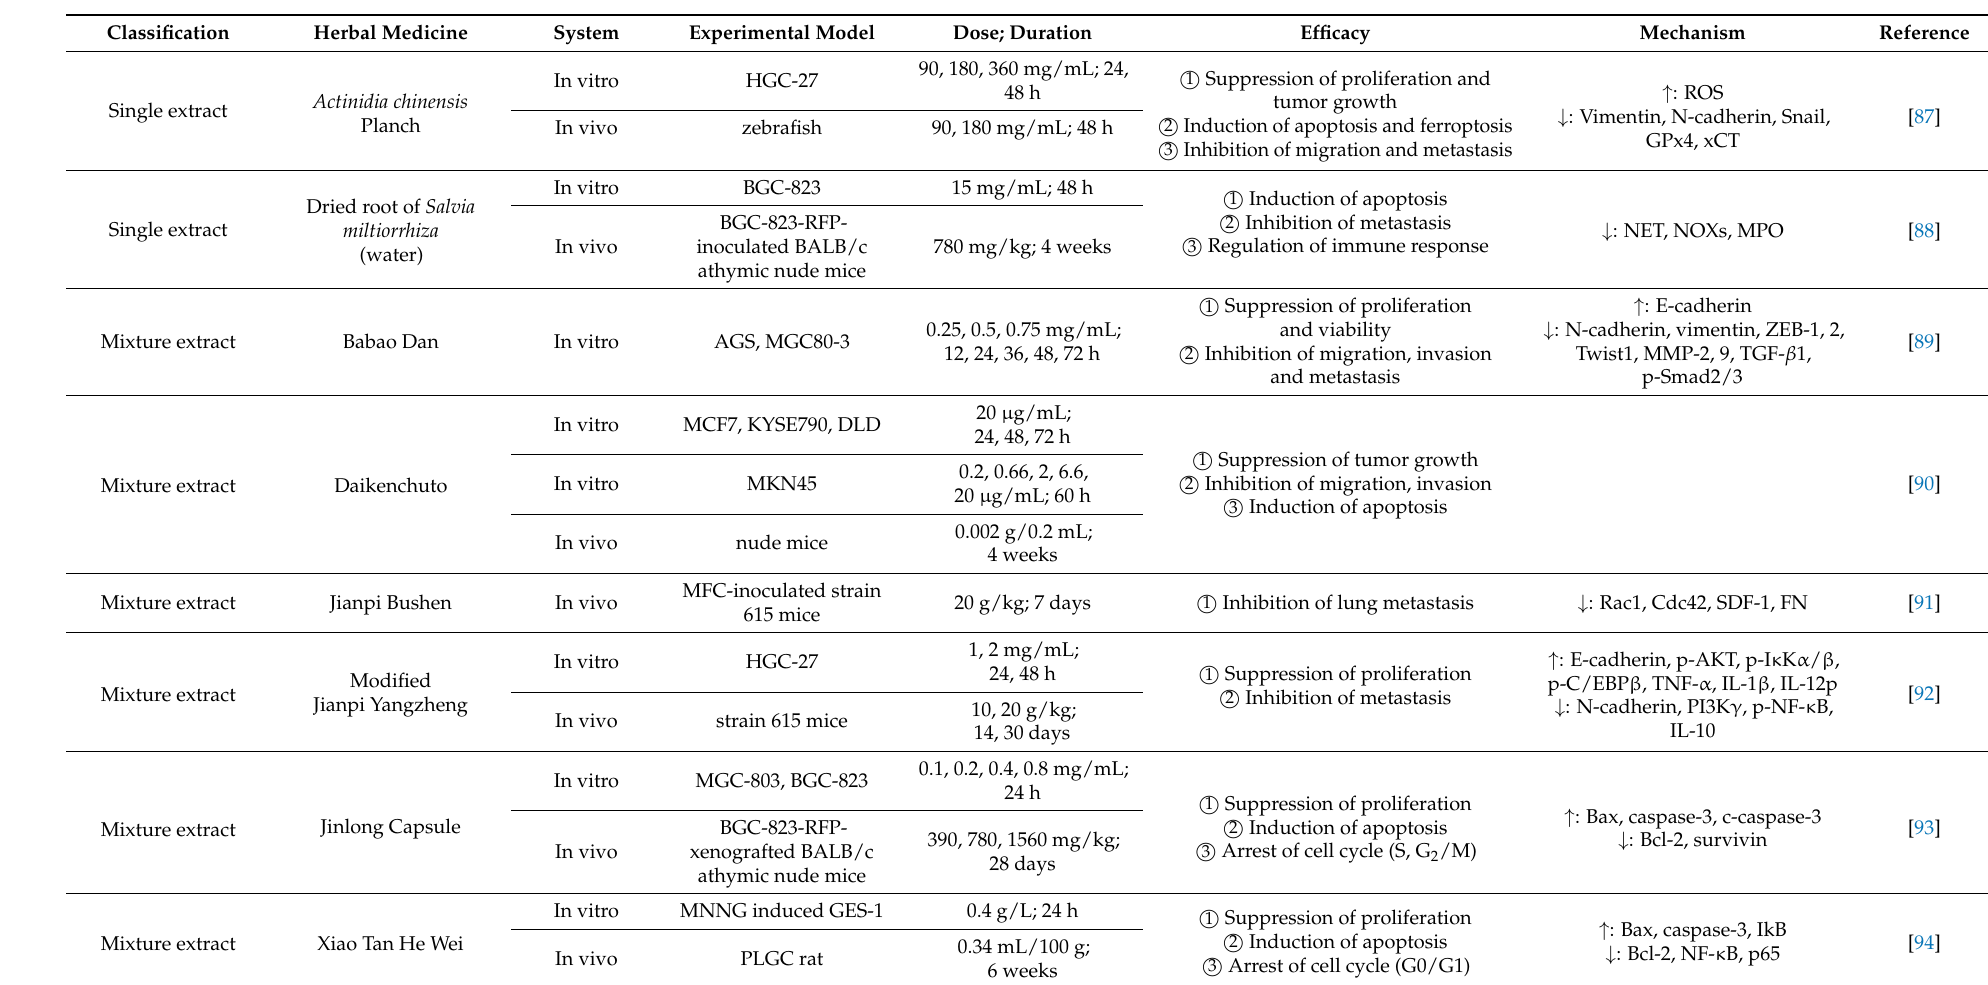
Table 4. Gastric